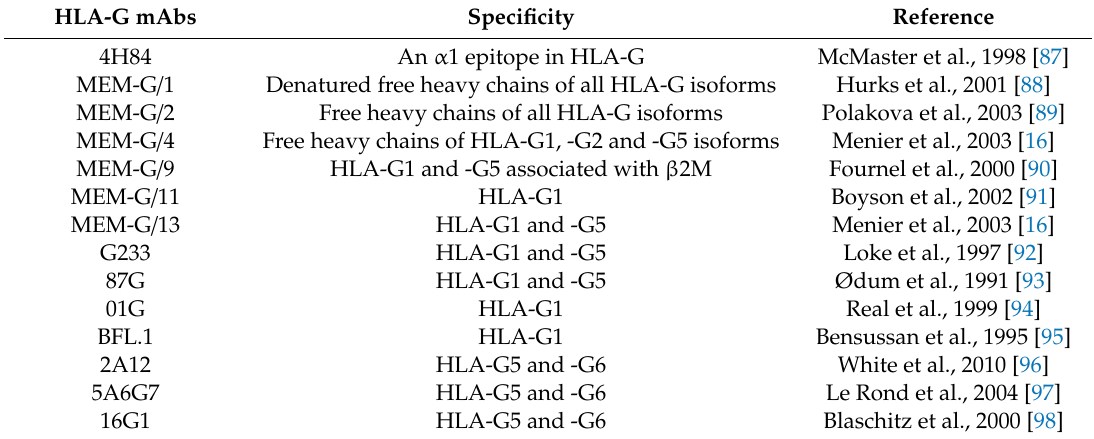
Table 2. Overview of HLA-G-recognizing antibodies and their